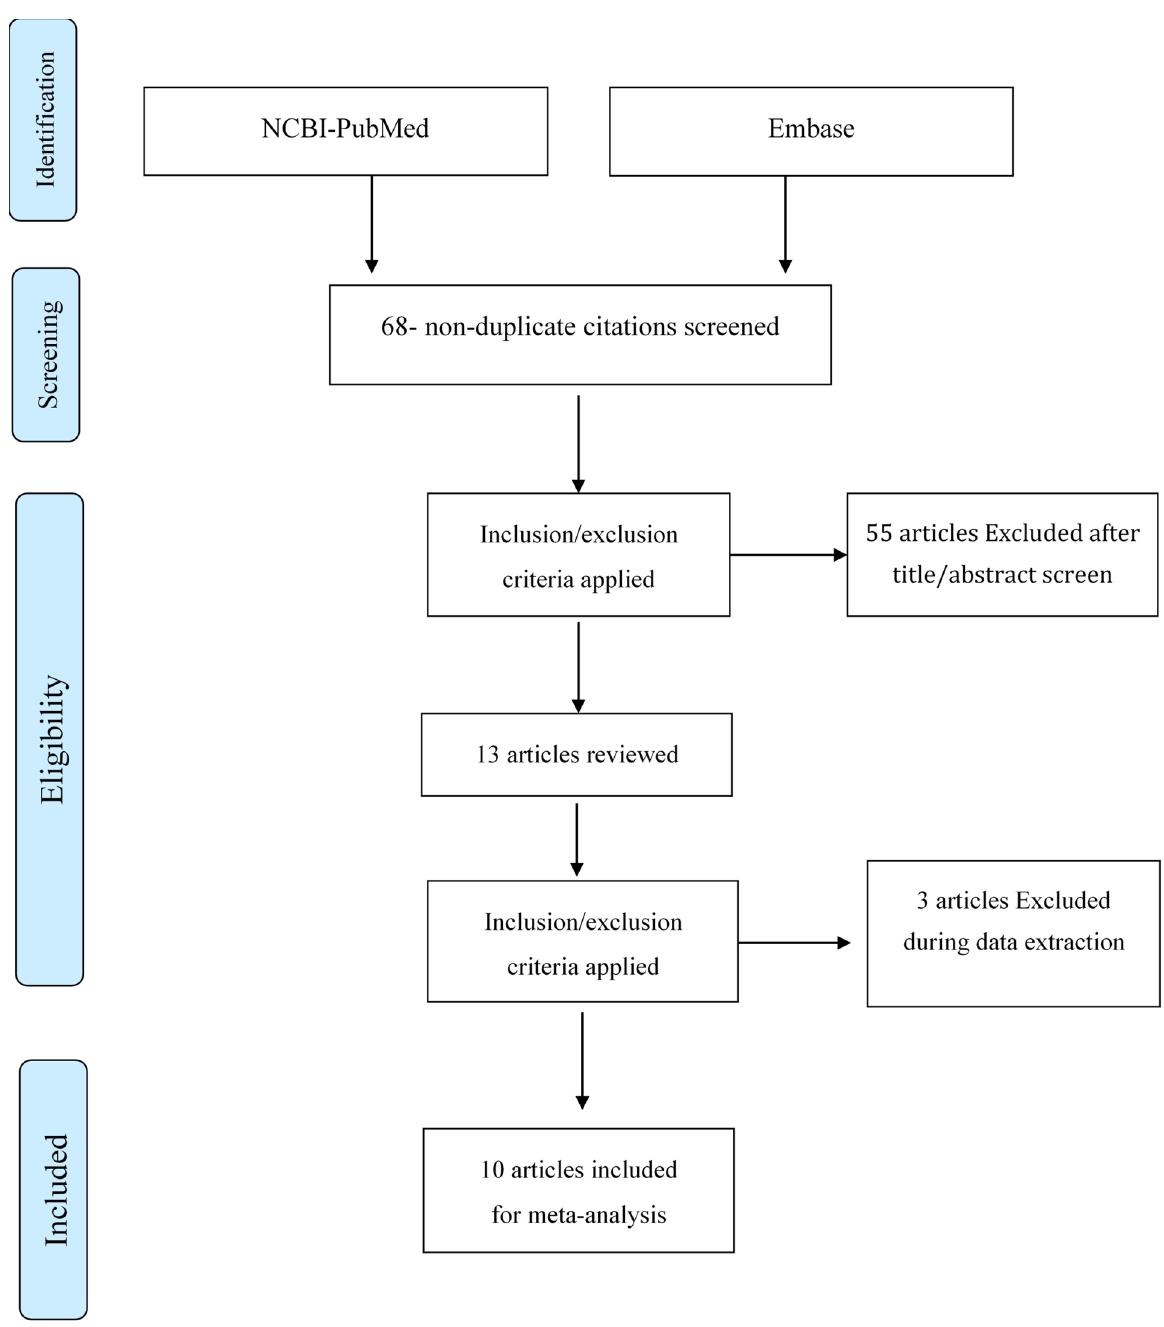
Figure 1. “PRISMA Diagram” depicting the flow of information across the various phases of a Systematic Review.